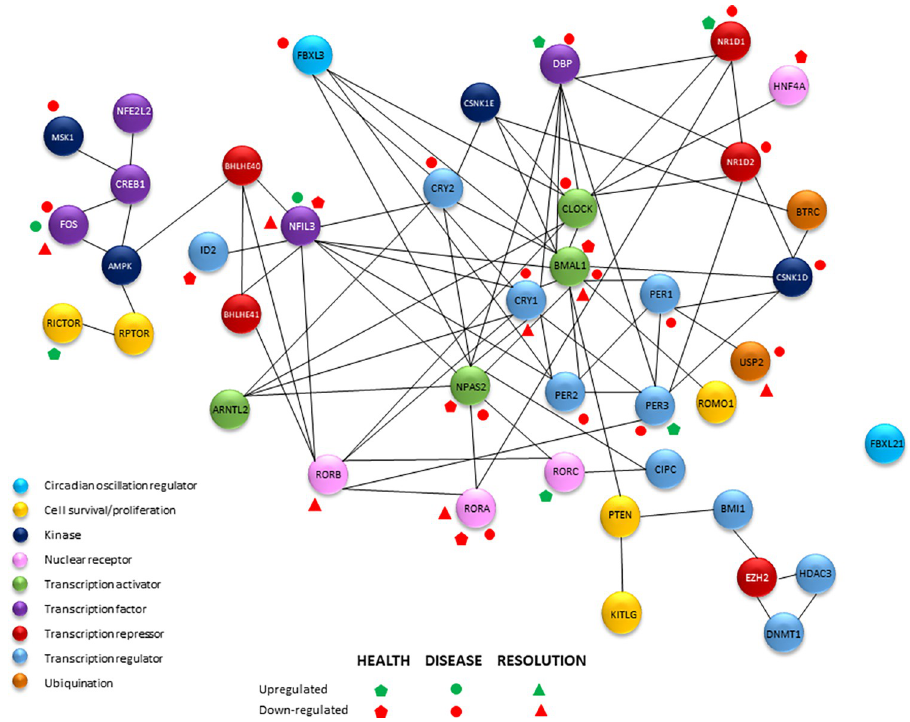
Fig 5. Schematic of interactome of circadian rhythm and circadian-associated genes denoted by black lines connecting the nodes. Colored nodes denote functional categorization of each gene. Green and red symbols denote significant differences in expression in healthy samples (young/adolescent/aged versus adult) or comparing naturally- occurring disease (versus health) and ligature-induced disease (versus baseline healthy samples).